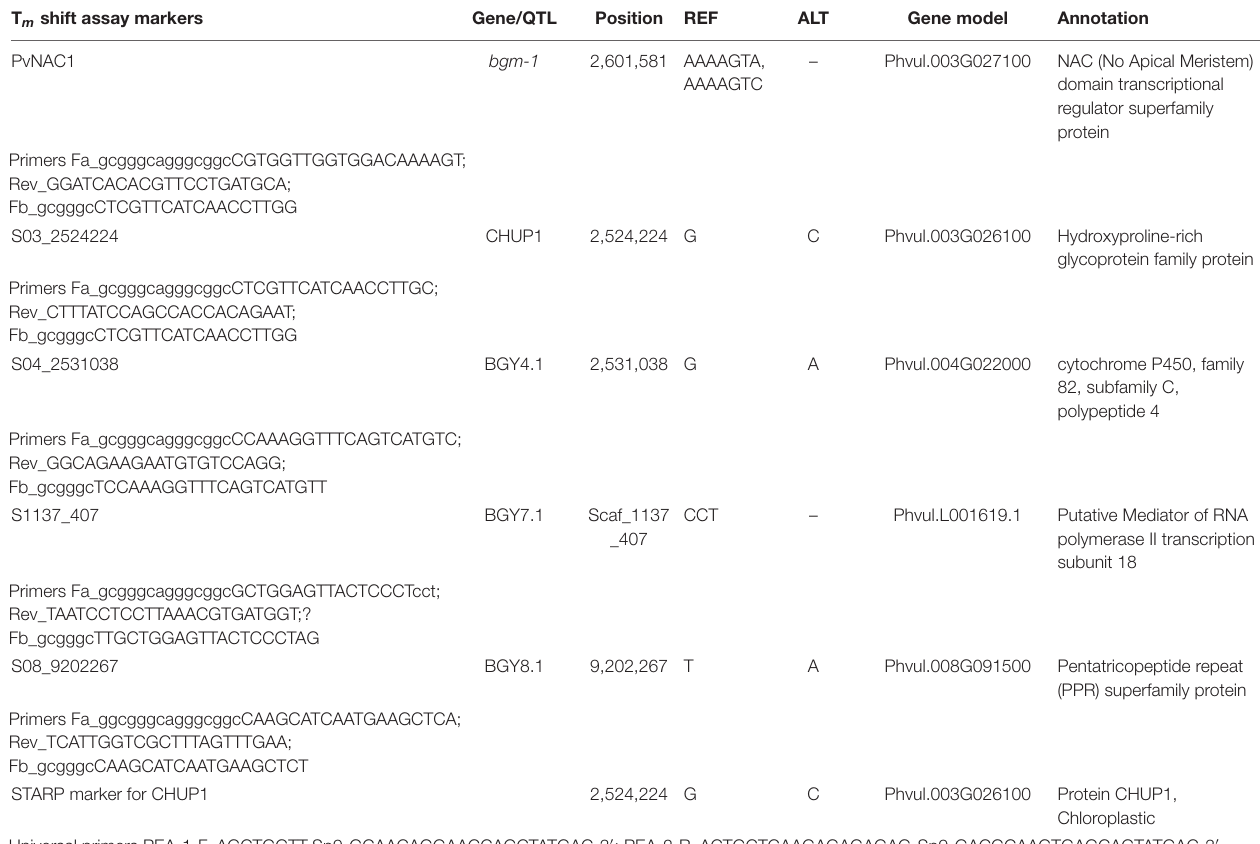
TABLE 2 | Primers used to generate markers for bgm-1 and QTL conditioning resistance to BGYMV. T m shift assay